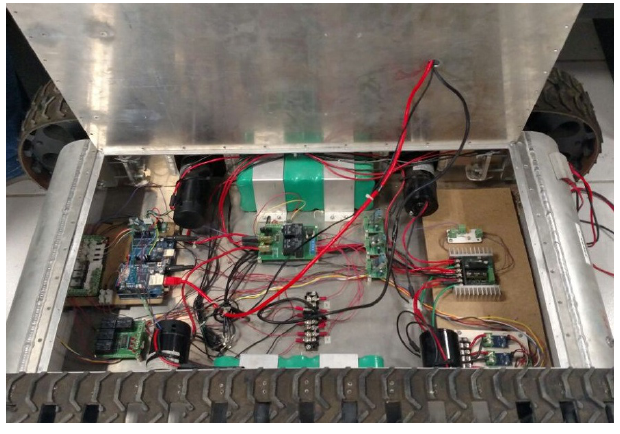
Figure 4. The interior of the Modified HD2 R (cid:13) Treaded ATR Tank